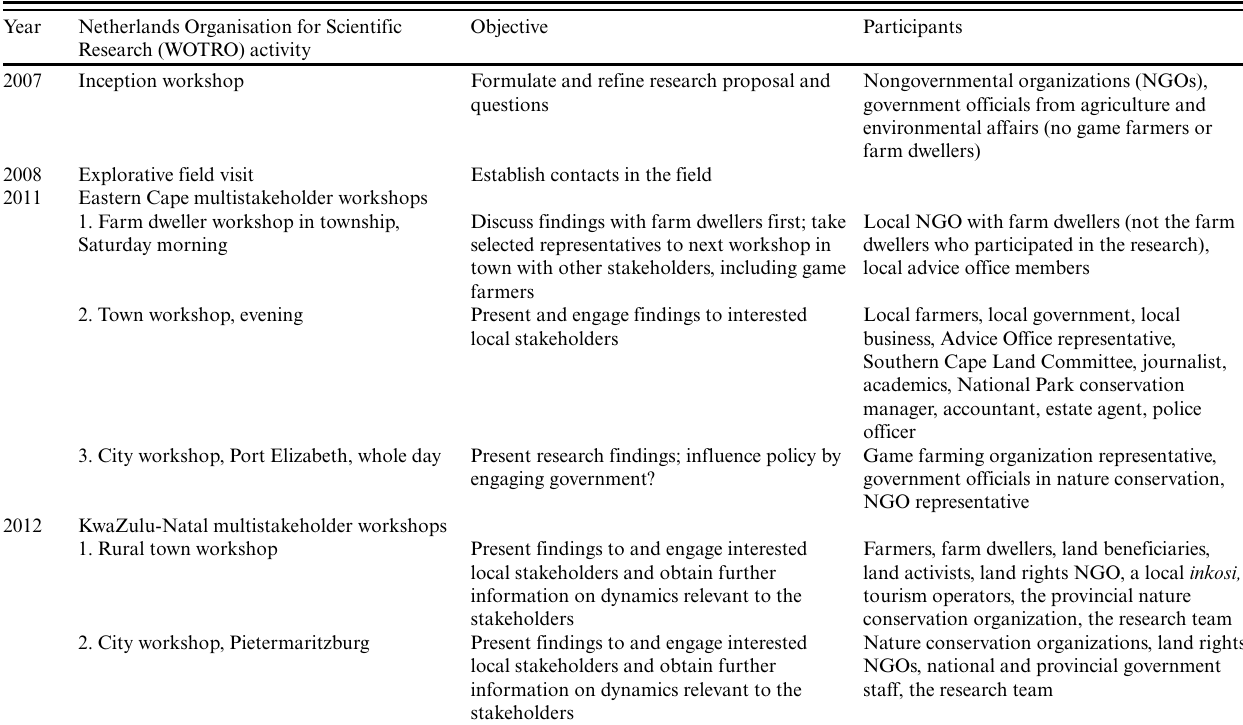
Table 1. Description of the multistakeholder engagement